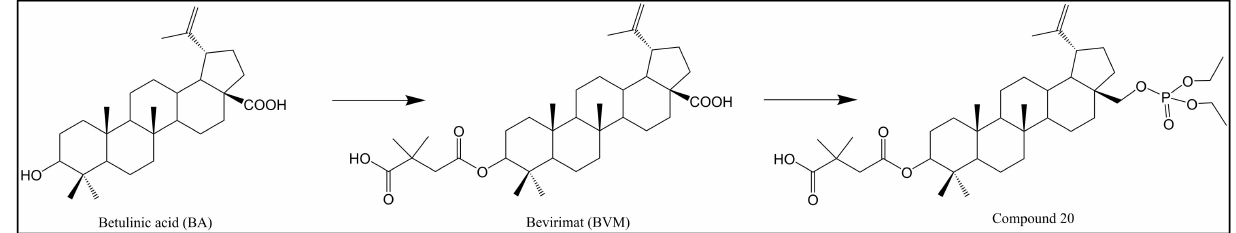
Figure 6. Chemical structures of betulinic acid (BA), bevirimat (BVM), and compound 20 . Betulin ( 17 ) is a natural pentacyclic lupane-structure triterpenoid that possesses a wide range of pharmacological activities and exhibited the highest inhibitory activity against HIV-1 integrase, with an IC 50 of 17.7 µ M, followed by BA ( 16 ) with an IC 50 value of 24.8 µ M. OA ( 8 ) and UA ( 10 ) showed moderate activity, with IC 50 values of 30.3 µ M and 35.0 µ M, respectively [45]. In addition, OA ( 8 ) from olives was found to completely inhibit HIV-1 protease inhibition, with an IC 50 value of 57.7 µ M